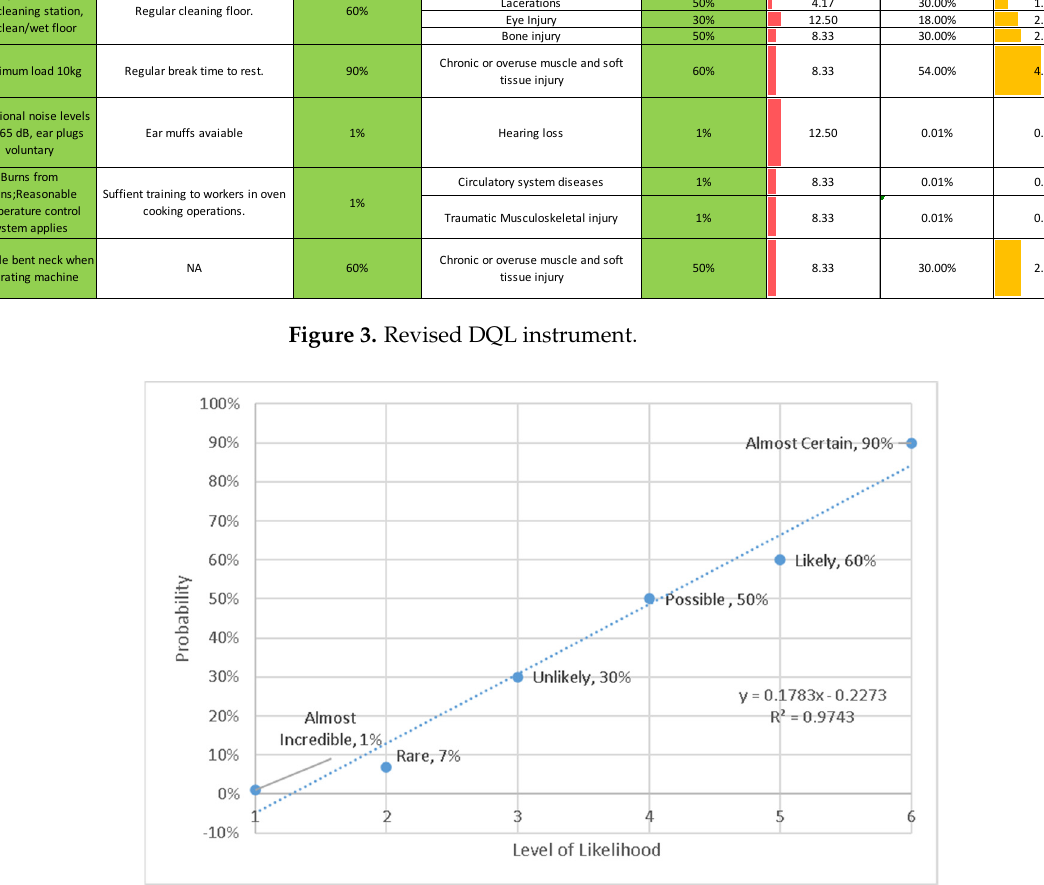
Figure 4. Original likelihood scale [12] (scale from Almost Incredible “1” to Almost Certain “6”).